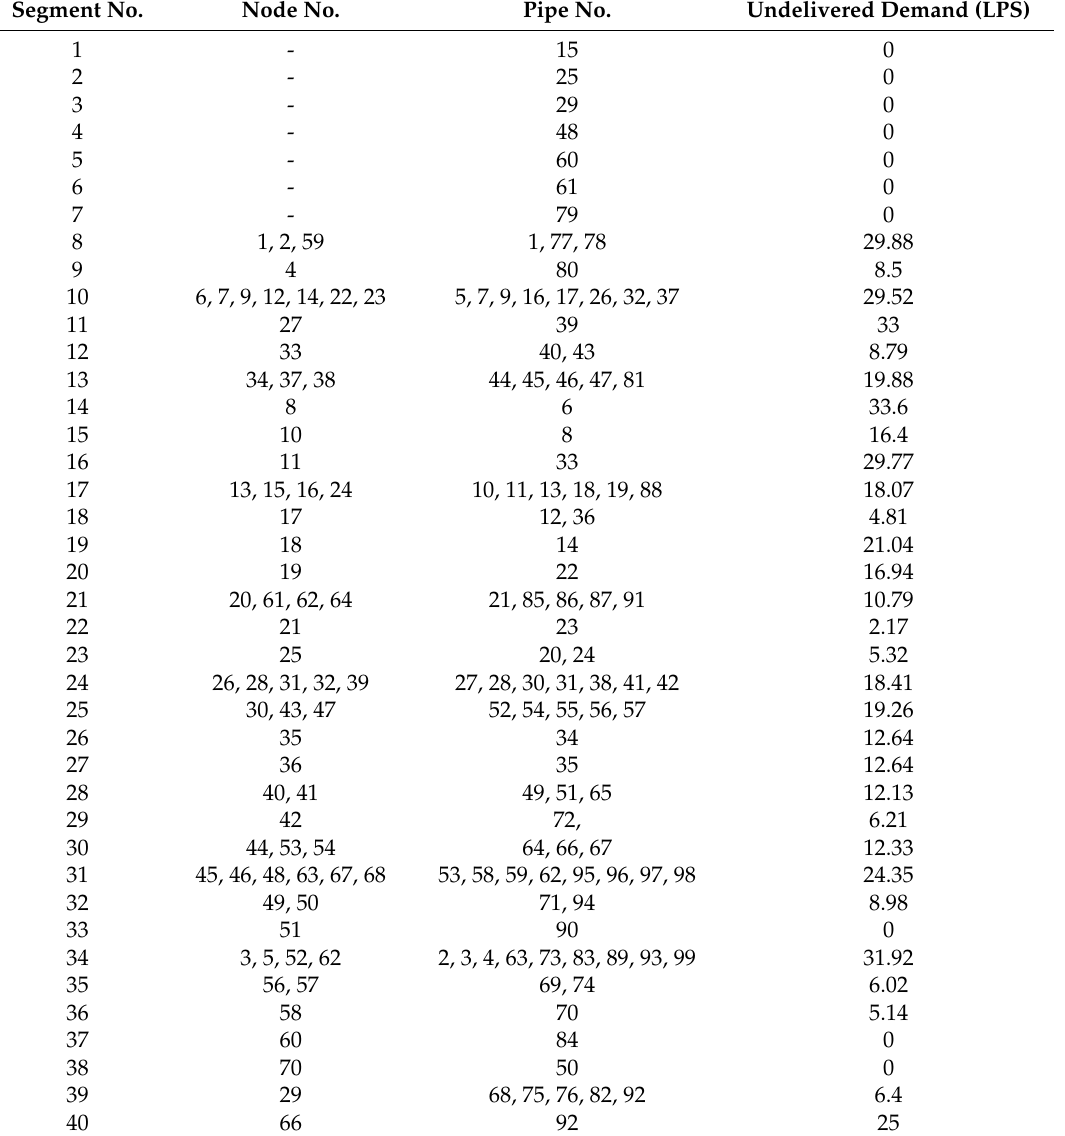
Table 8. Result of optimal valve installation after top five segment